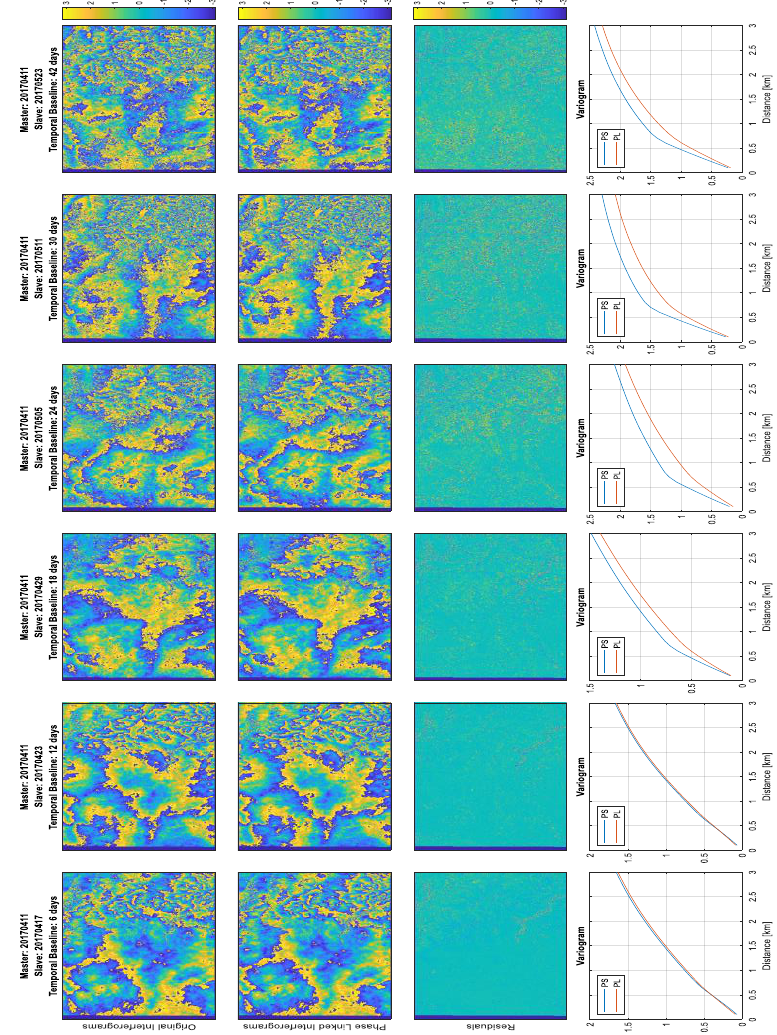
Figure 8. A comparison between the standard interferogram (top row), the phase linked (middle row) and their residual (bottom row). In the last row the variograms for DInSAR (PS) and Phase Linking (PL) are shown.